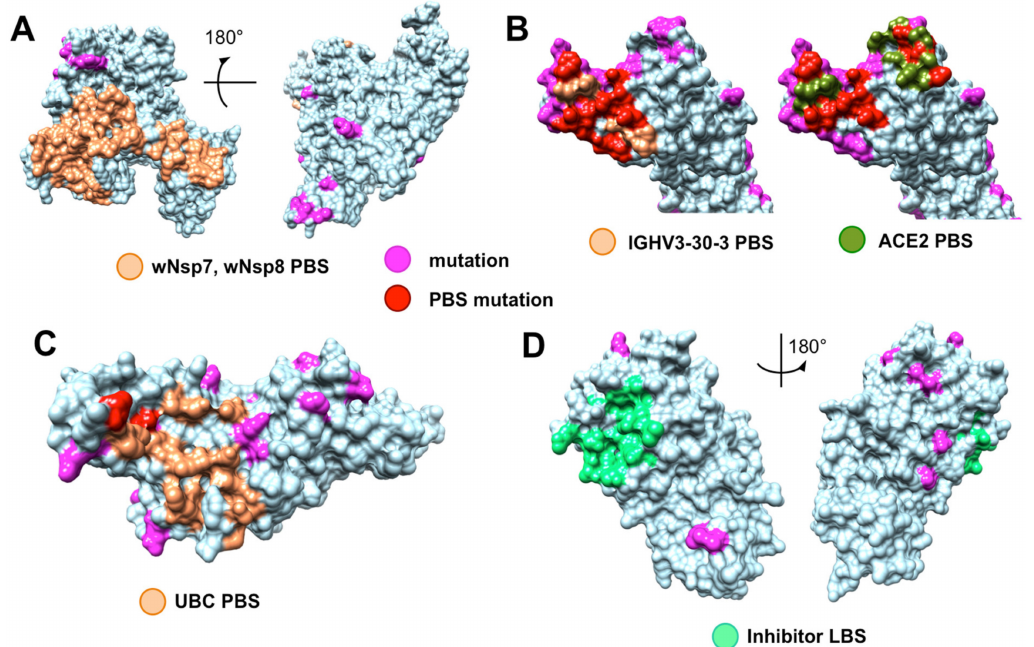
Figure 4. Evolutionary conservation of functional sites in SARS-CoV-2 proteins. ( A ) Fully conserved protein binding sites (PBS, light orange) of wNsp12 in its interaction with wNsp7 and wNsp8, while other parts of the protein surface shows mutations (magenta); ( B ) Both the major monoclonal antibody binding site (light orange) and the ACE2 receptor binding site (dark green) of wS are heavily mutated (binding site mutations are shown in red) compared to the same binding sites in other coronaviruses; mutations not located on the two binding sites are shown in magenta; ( C ) Nearly intact protein binding site (light orange) of wNsp (papain-like protease PLpro domain) for its putative interaction with human ubiquitin-aldehyde (binding site mutations of the only two residues are shown in red, non-binding site mutations are shown in magenta); ( D ) Fully conserved inhibitor ligand binding site (LBS, green) for wNsp5; non-binding site mutations are shown in magenta.